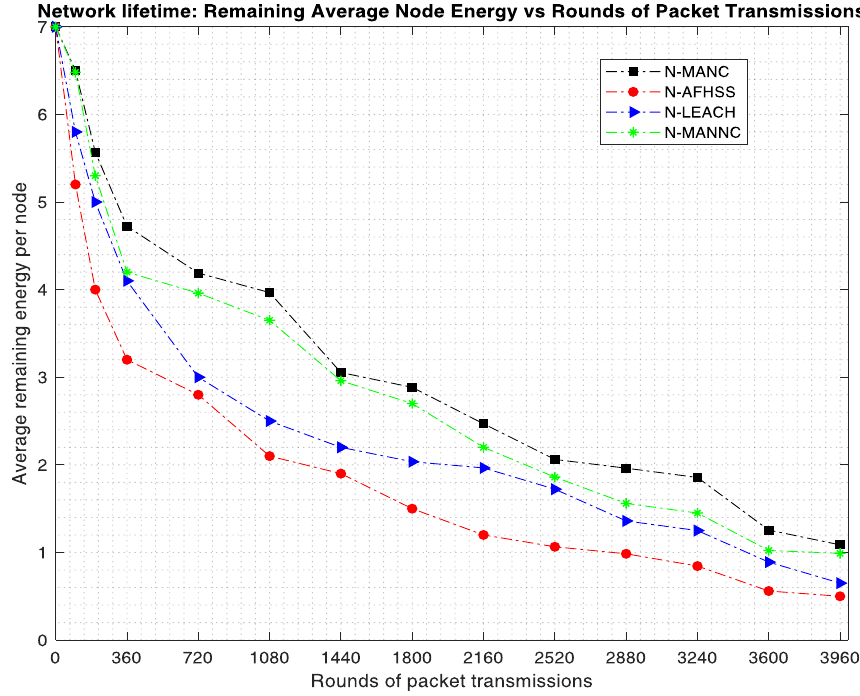
Figure 7. Network lifetime: remaining average energy versus round of transmission